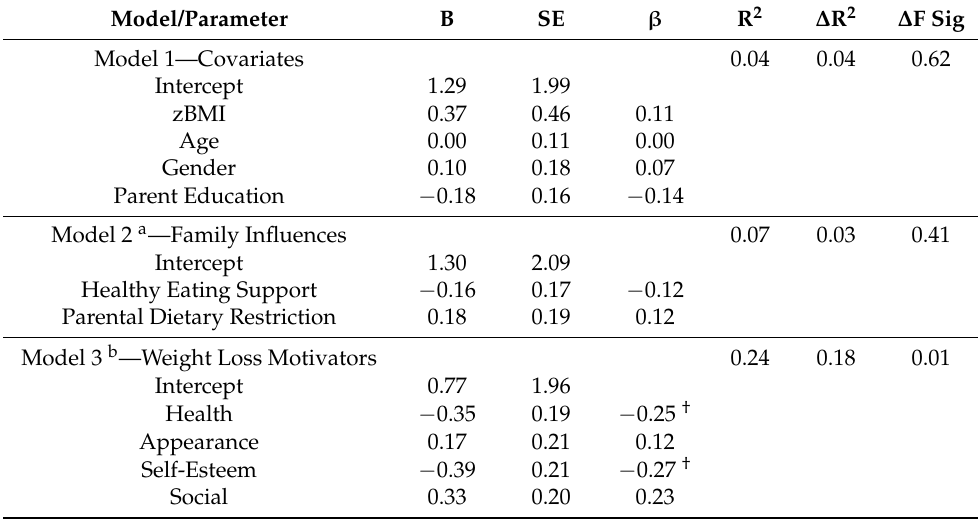
Table 4. Regression analyses assessing associations of family factors and weight loss motivators with fast food